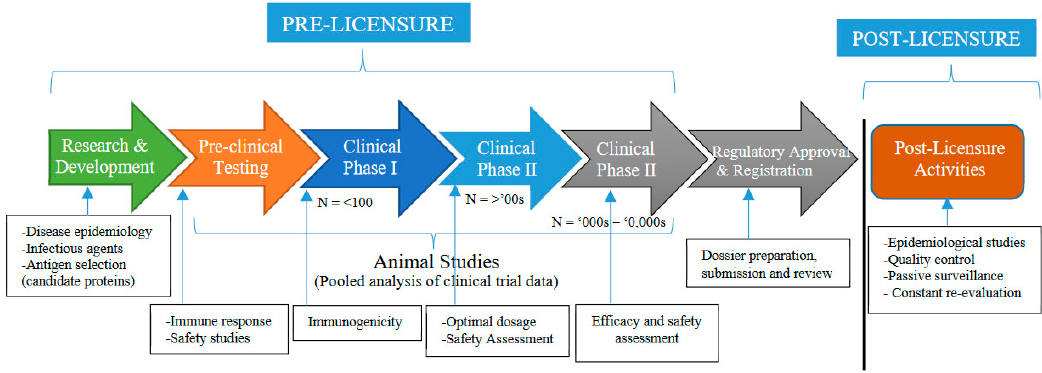
Figure 2. Stages in vaccine development. Source: Adapted from [61,62].